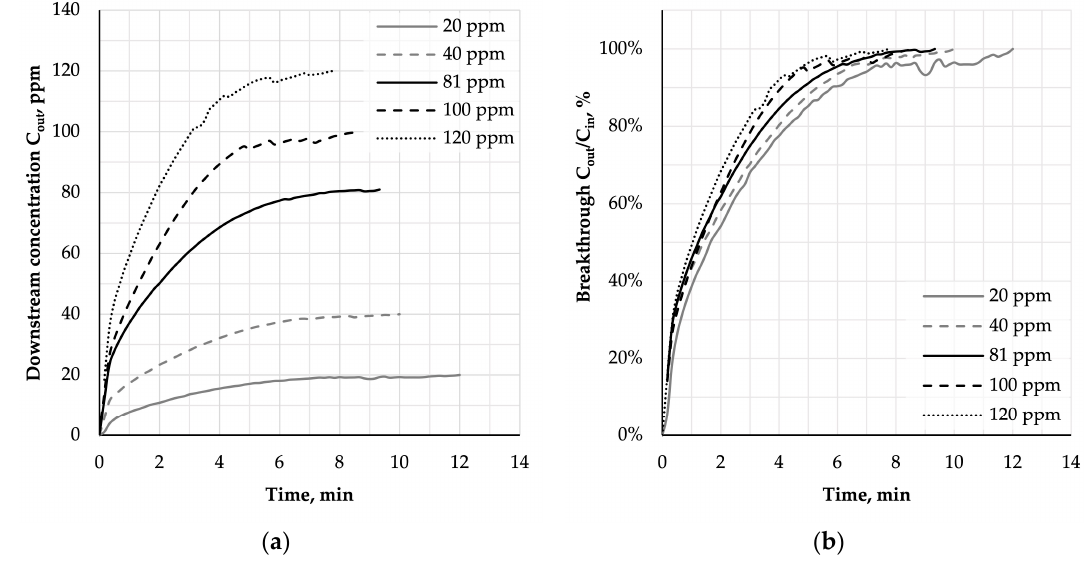
Figure 6. Downstream concentration ( a ) and breakthrough percentages ( b ) for AC-NW media in time.